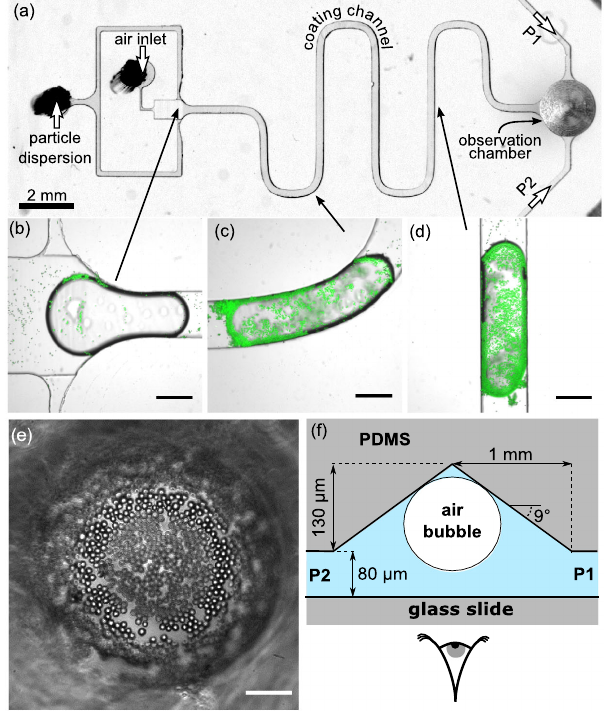
FIG. 1. (a) General view of the microfluidic device which consists of a bubble formation zone, a coating channel, and an observation chamber. (b) – (d) Composite bright-field or fluores- cence images where the particles appear in green. (b) First, a slopped injector (height ¼ 30 μ m to 80 μ m, angle 2.3°) produces a single air bubble. (c,d) The bubble is then squeezed through the coating channel by the flow of a particle dispersion where it progressively collects particles. Scale bars are 200 μ m. The armored bubble is then released in the observation chamber, and the excess of unattached particles in suspension is washed away, yielding a bubble coated with a single layer of particles with loosely packed crystalline domains. (e) Phase contrast micrograph of such a bubble with 4 . 5 - μ m diameter particles. The scale bar is 30 μ m. (f) Cross-section schematic of the conical observation chamber (not to scale). The air bubble is trapped even if the liquid around it is [Figs. 1(c) and 1(d)] [27,28]. The coated bubble is then